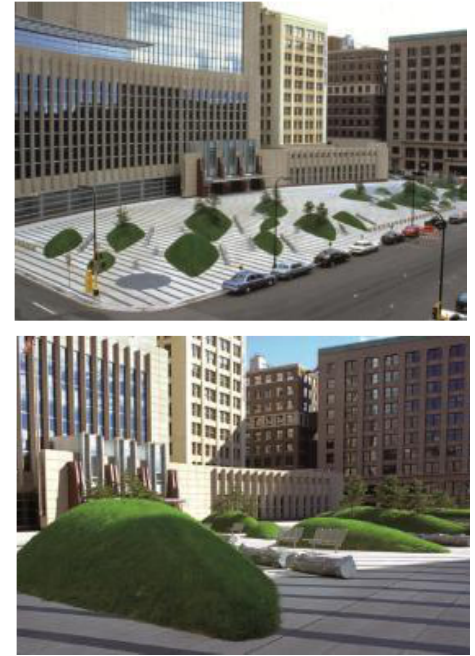
Figure 5. The Minneapolis courthouse plaza. Small lawn hills and logs prevent possible vehicle attacks along the facade of the building (FEMA,